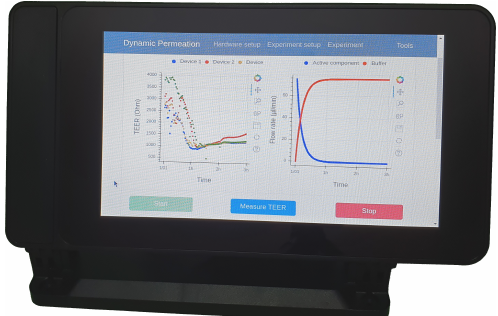
Figure 5. Measurement software with the graphical user interface (GUI) running on the RaspberryPi control